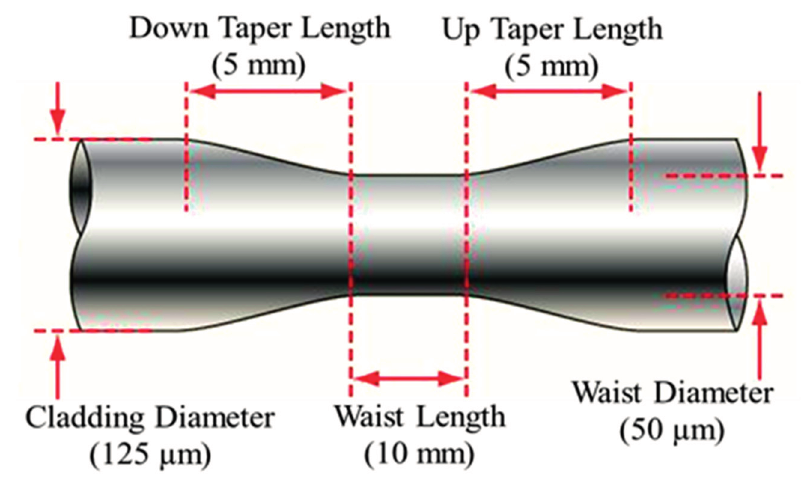
Figure 1. Tapered fiber